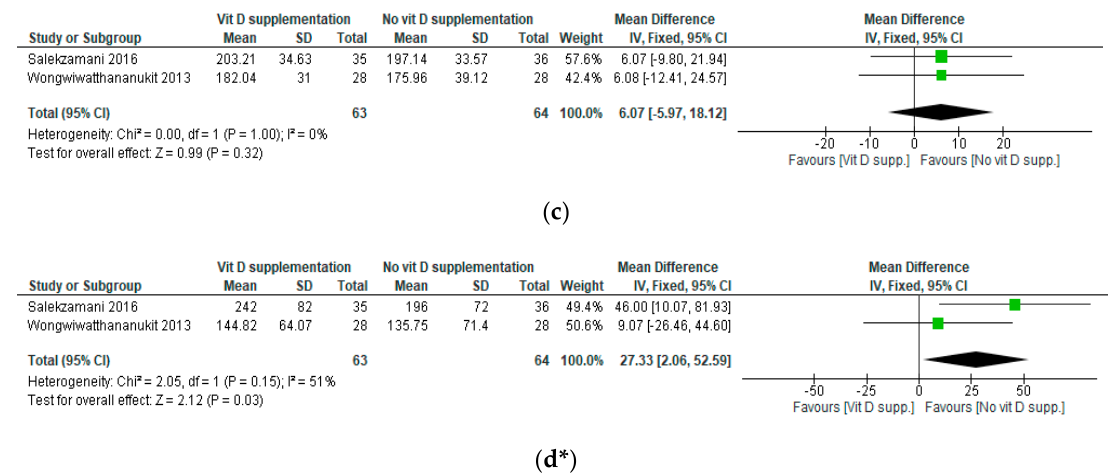
Figure 4. Meta-analysis of effects of high-dose VDS on LDL-C, HDL-C, TC, and TG. Mean differences for each study are represented by squares, and 95% Confidence Intervals are represented by the lines through the squares. The pooled mean differences are represented by diamonds. Between-study heterogeneity was assessed with the use of the I 2 statistic. VDS: Vitamin D Supplementation; LDL-C: Low-density Lipoprotein Cholesterol; HDL-C: High-density Lipoprotein Cholesterol; TC: Total Cholesterol; TG: Triglycerides. ( a ) Forest plot of mean differences in LDL-C (in mg/dL) between subjects receiving a high dose of VDS compared with those not receiving VDS. ( b ) Forest plot of mean differences in HDL-C (in mg/dL) between subjects receiving a high dose of VDS compared with those not receiving VDS. ( c ) Forest plot of mean differences in TC (in mg/dL) between subjects receiving a high dose of VDS compared with those not receiving VDS. ( d ) Forest plot of mean differences in TG (in mg/dL) between subjects receiving a high dose of VDS compared with those not receiving VDS. * The mean differences of the two studies are very different and the heterogeneity is 51%. This might be due to the study by Salekzamani et al. [36] since TG at baseline was significantly higher in the intervention group compared with the control group.